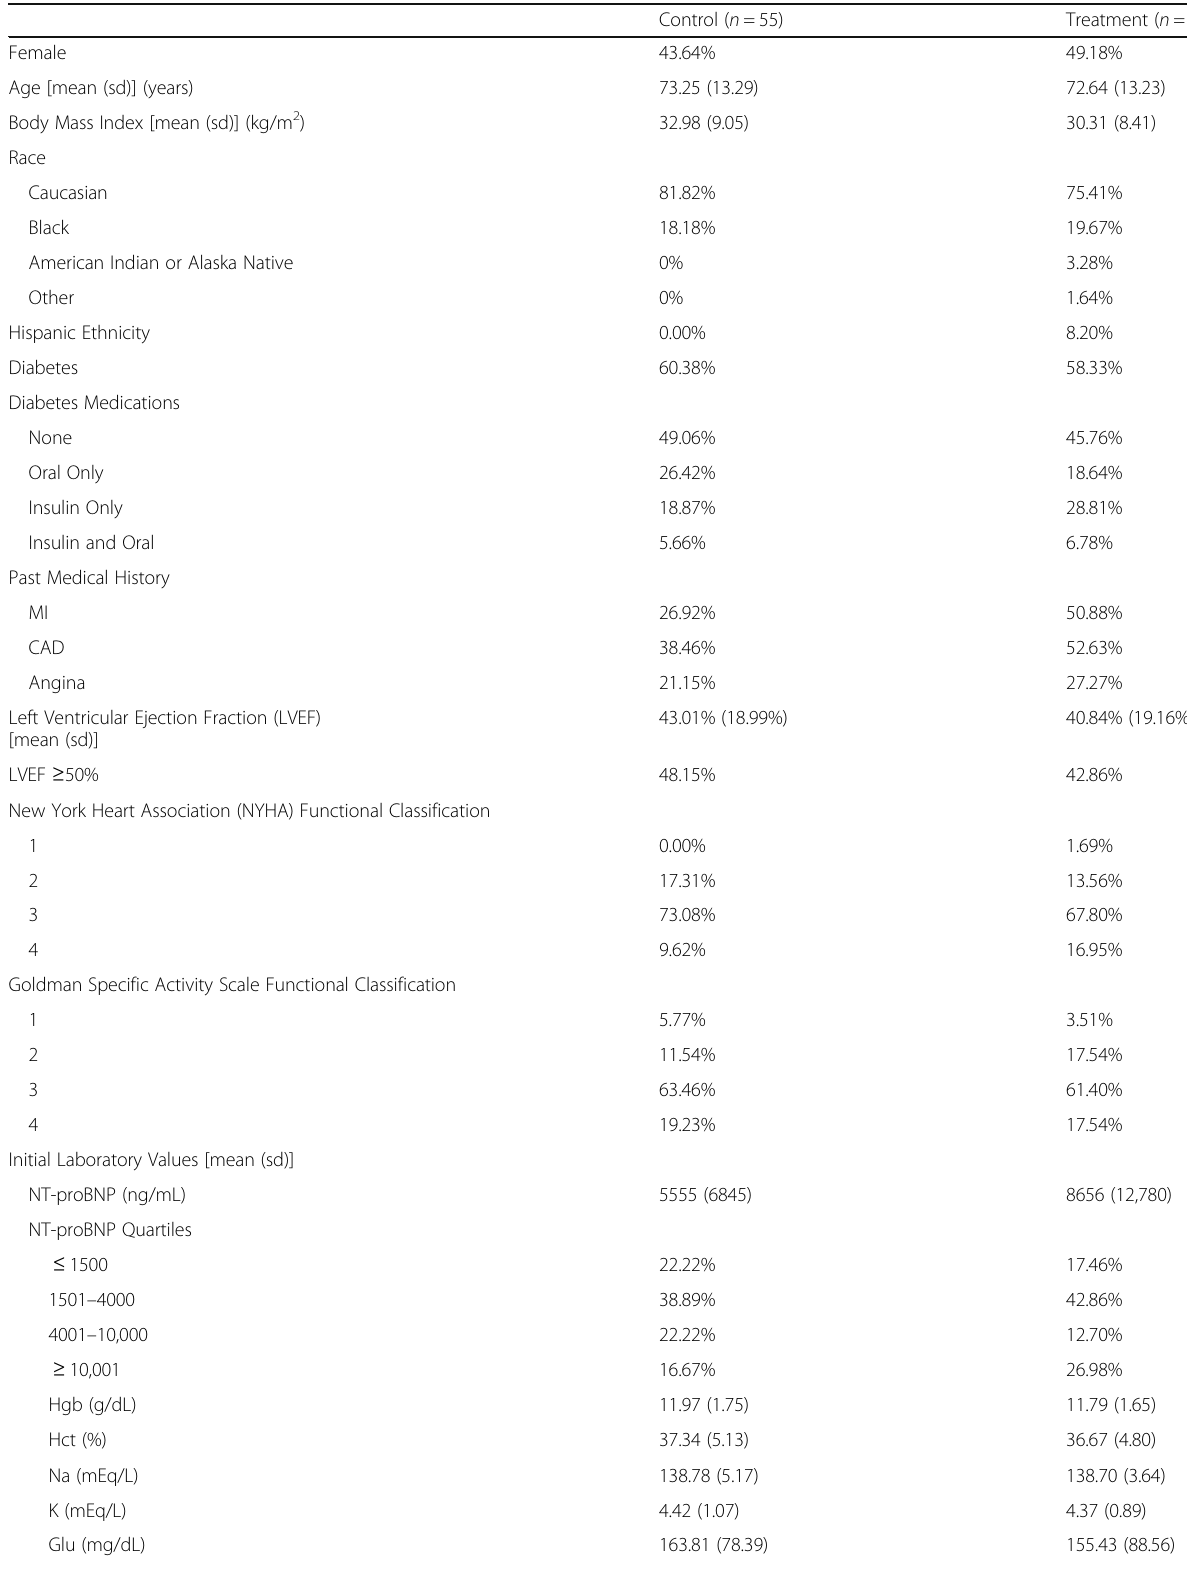
Table 1 Subject